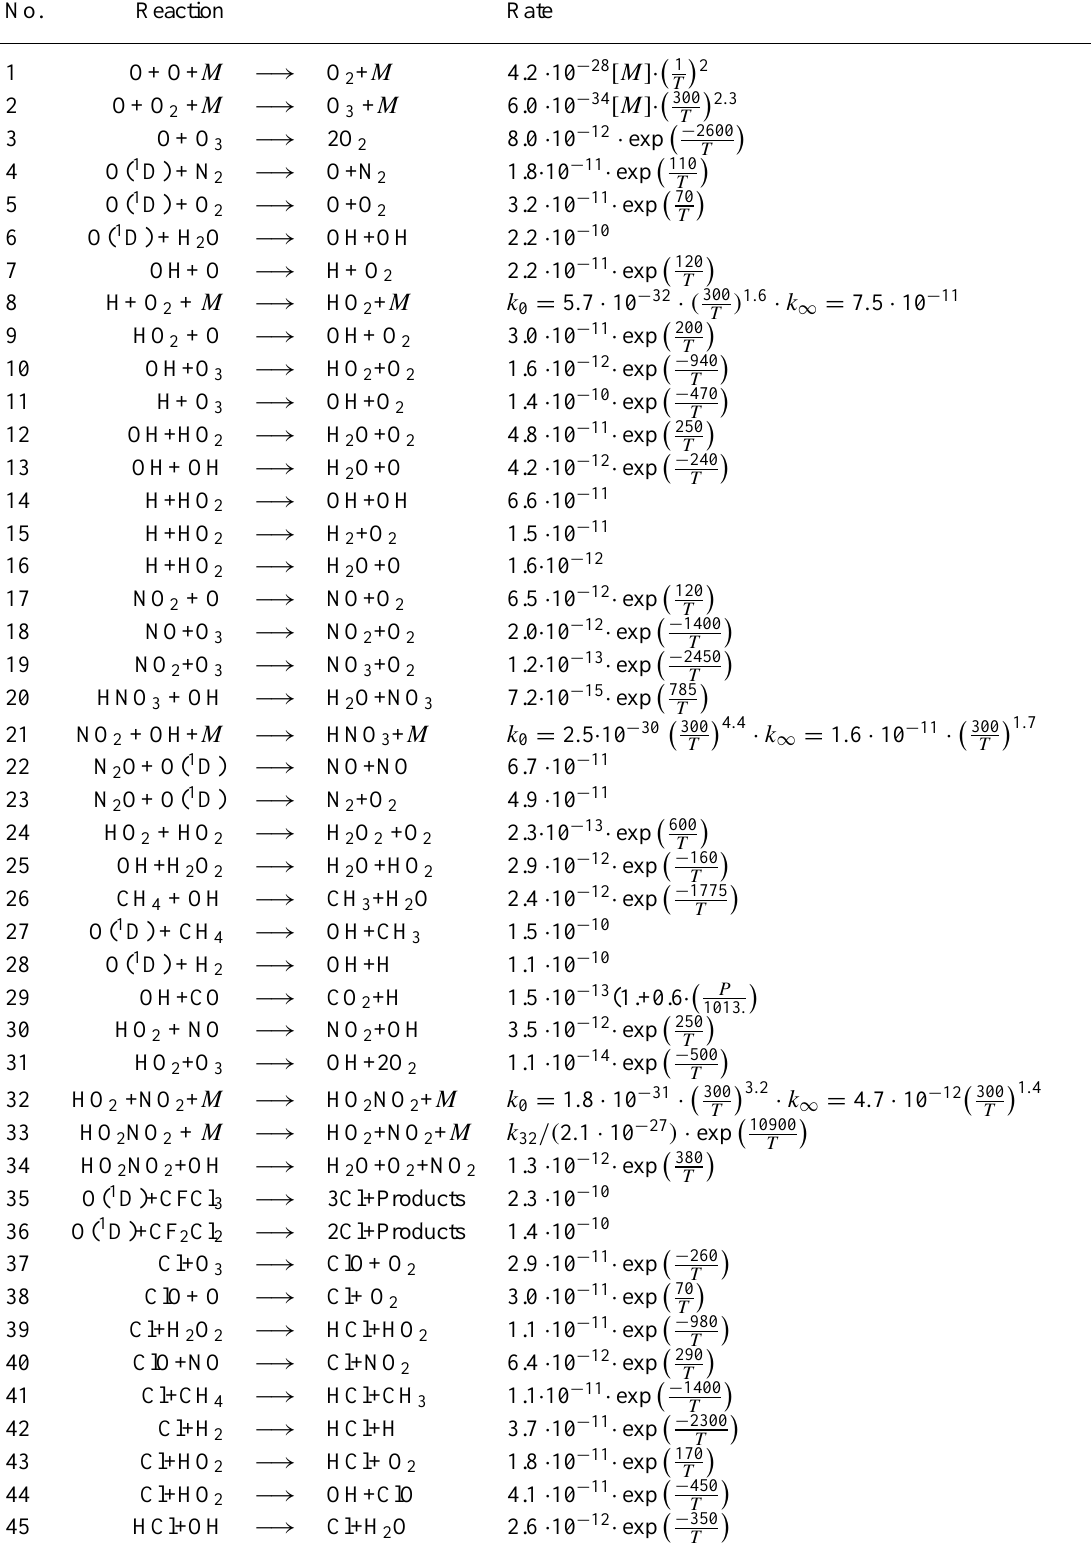
Table 4. Chemical reaction mechanism and kinetic rates No.